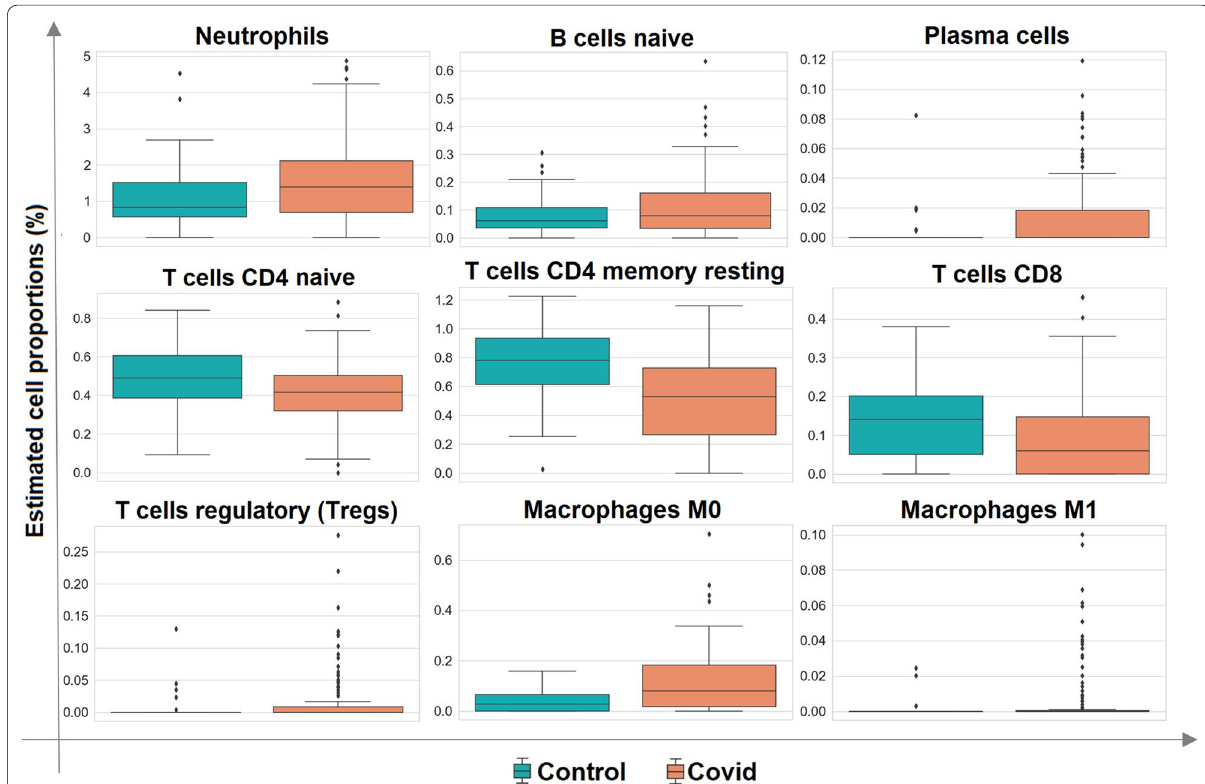
Fig. 3 Cell-type proportions in whole blood of COVID-19 in comparison to healthy control: the box plots for the estimated immune cell type proportions of the COVID-19 patients and the HC individuals which were obtained by Cibersortx. HC healthy control